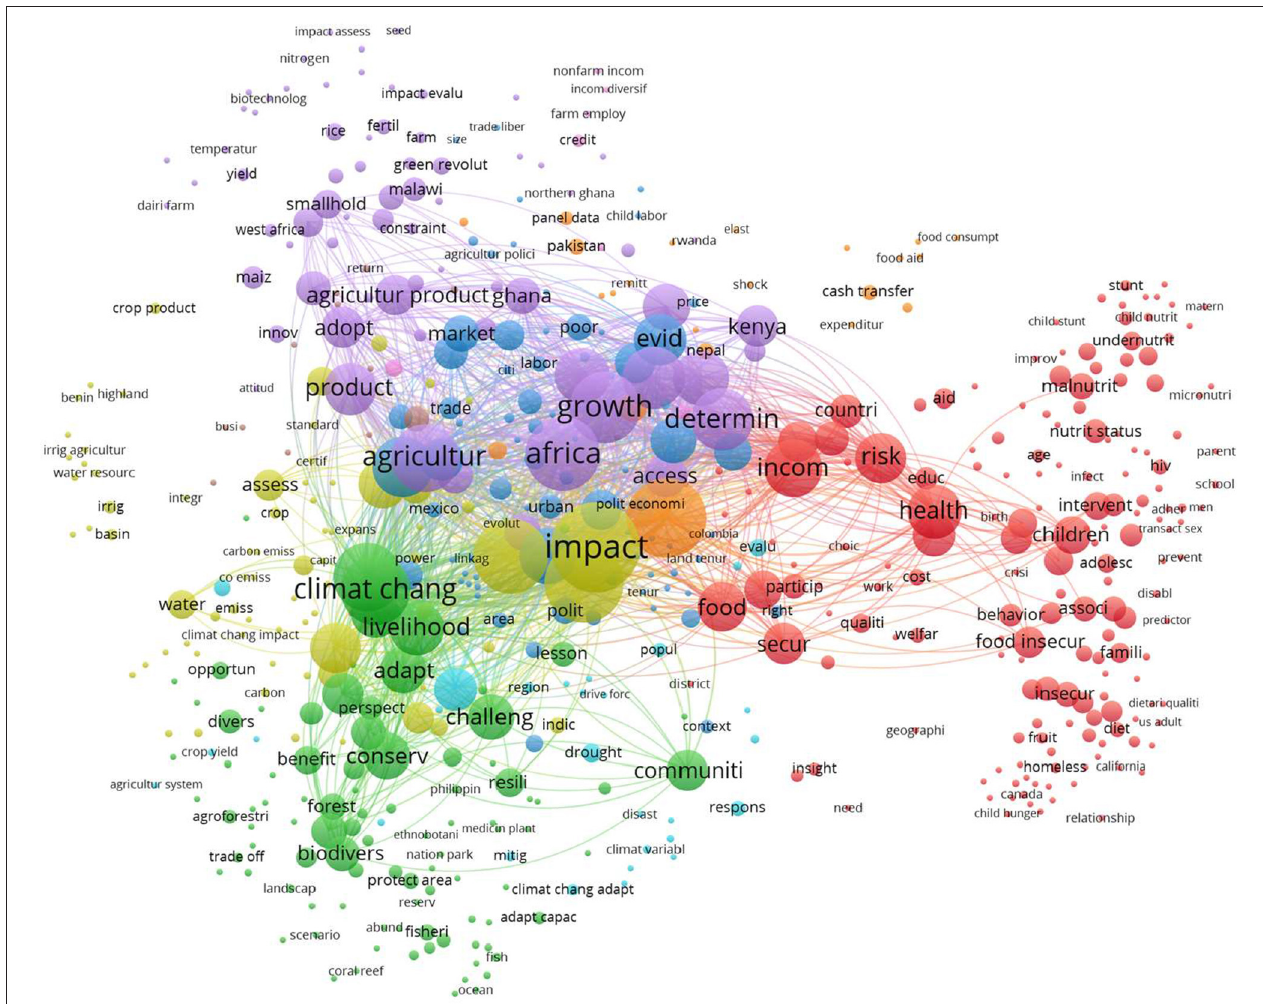
FIGURE 4 | Cooccurrence network of B-terms in food security and poverty